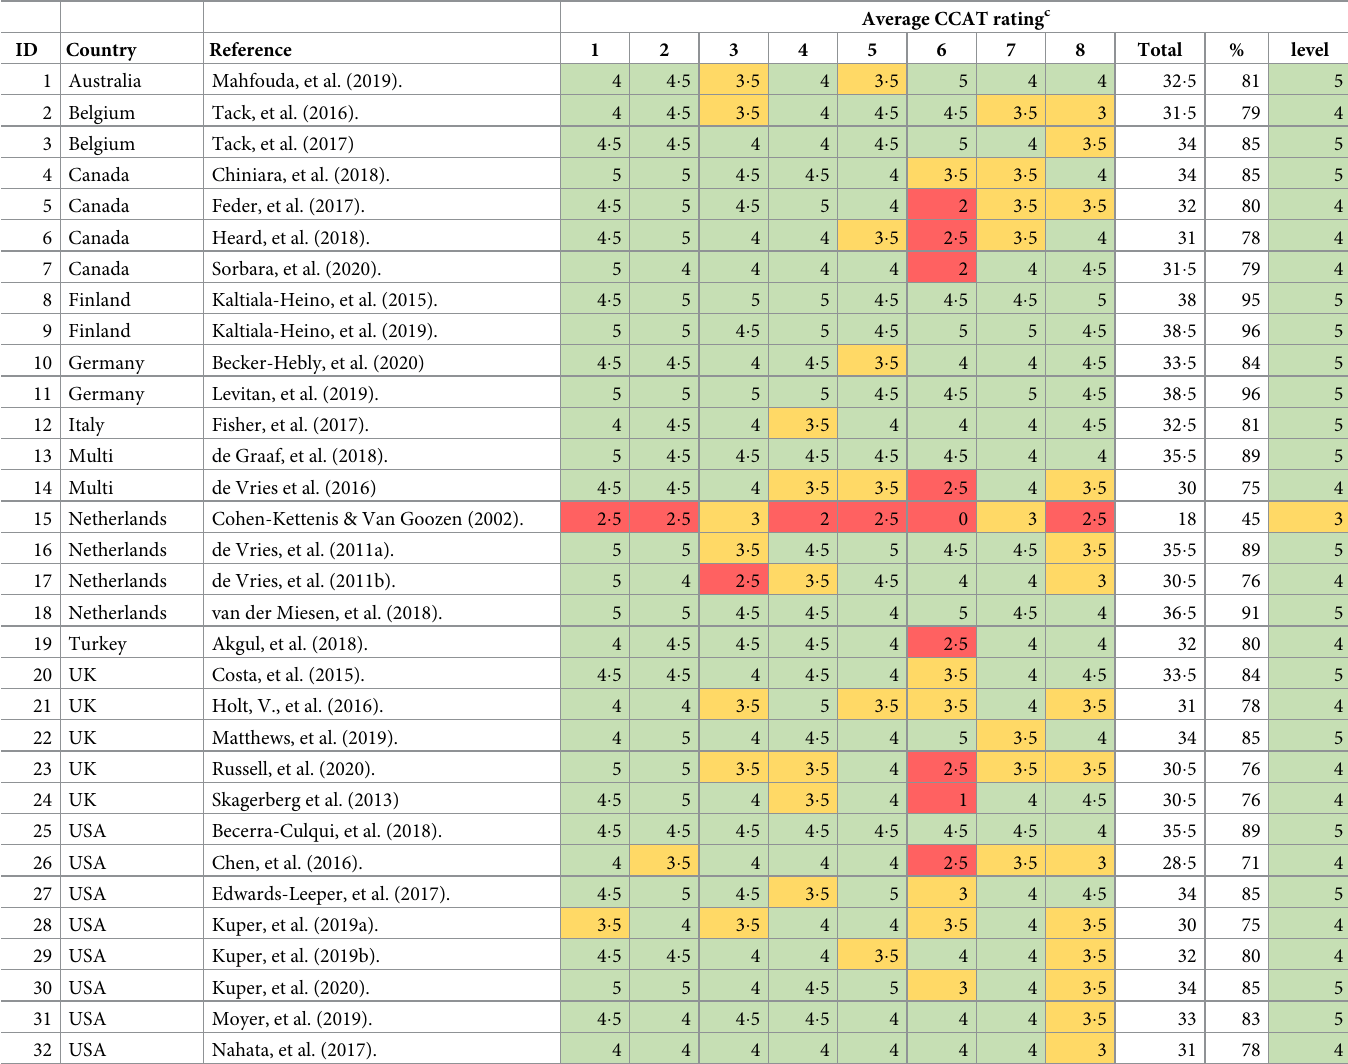
Table 3. Quality ratings using Crowe Critical Appraisal Tool (CCAT)